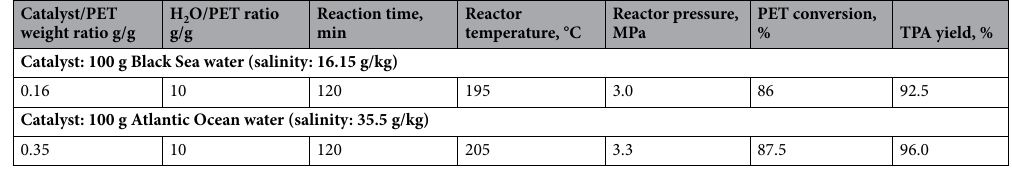
Table 4. Experimental data of PET depolymerization by hydrolysis with marine water.